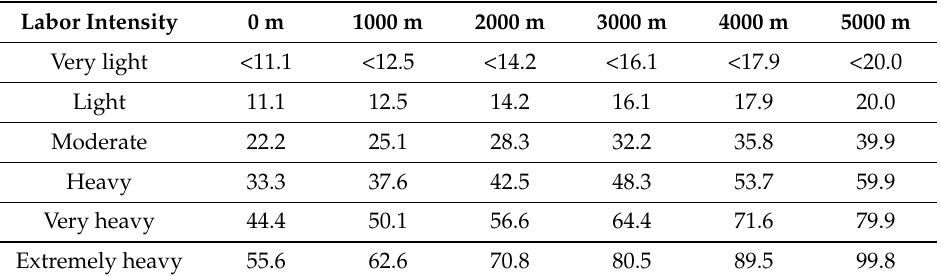
Minimum ventilation of human body under different labor intensities at different altitudes